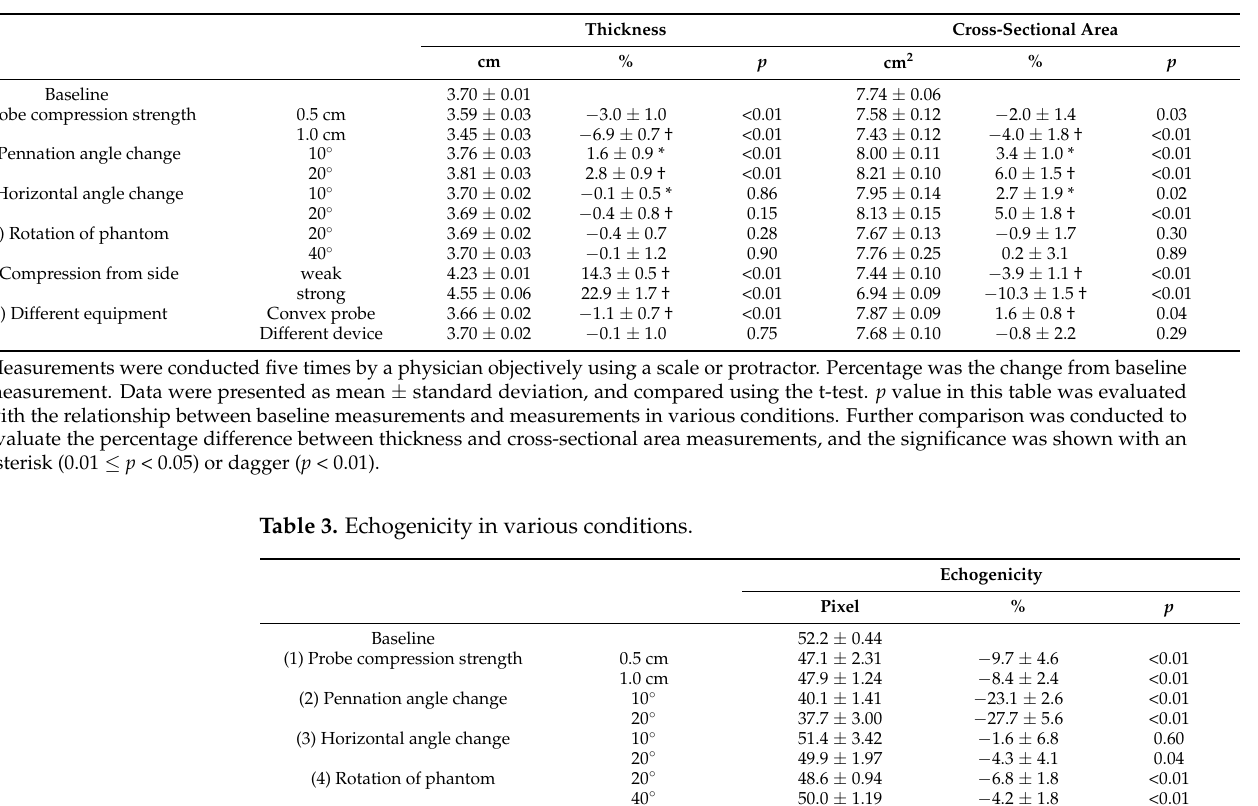
Table 2. Thickness and cross-sectional area.